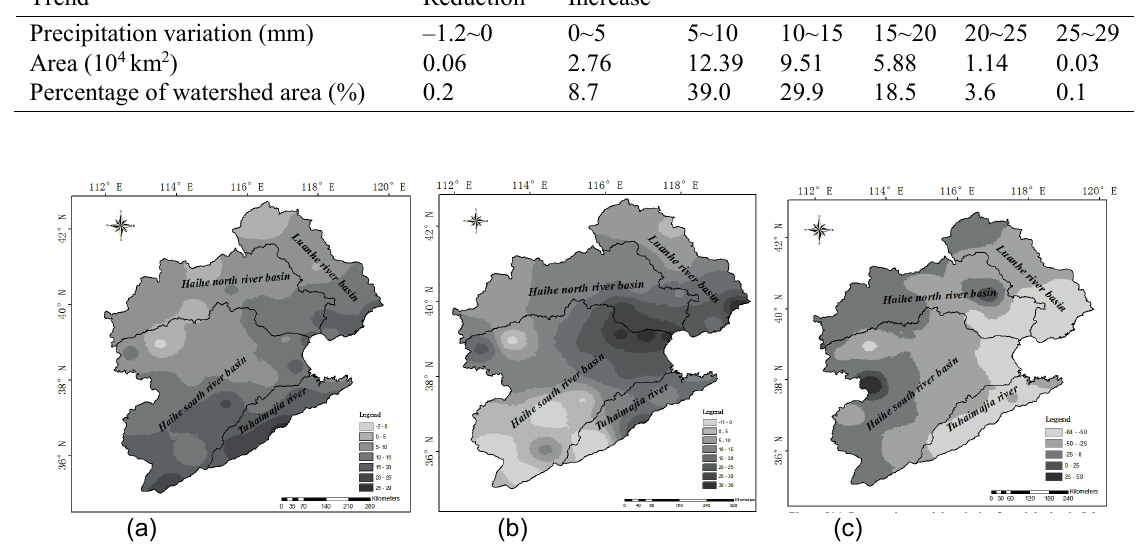
Fig. 5 Comparative spatial analysis of precipitation in (a) May, (b) June, and (c) July.